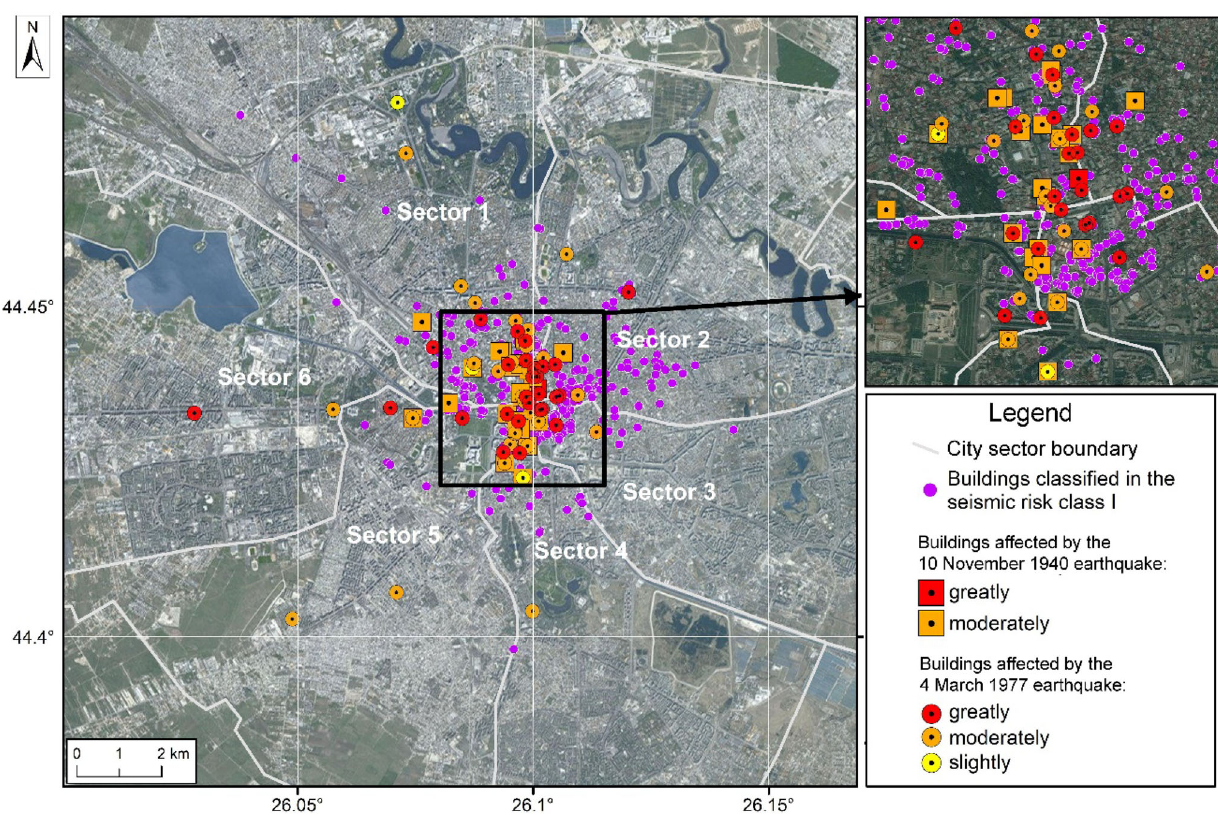
Fig. 2 Map of the buildings affected by the 1940 and 1977 earthquakes in Bucharest, and the buildings classified in seismic risk class I, according to Bucharest General Municipality (2016)